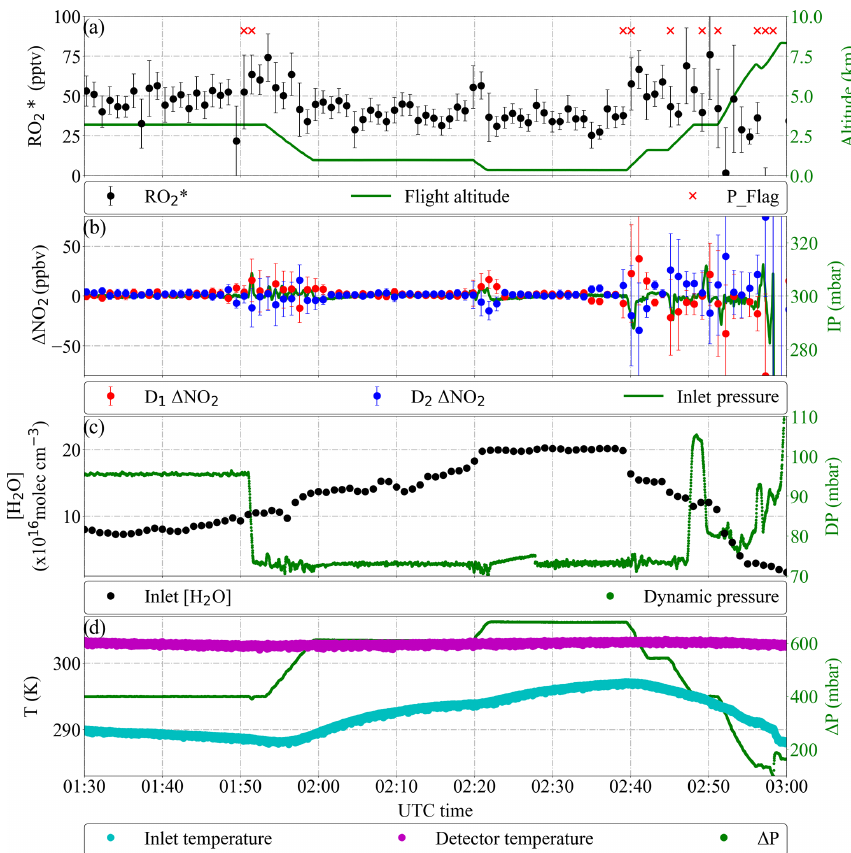
Figure 19. Detail of PeRCEAS measurements during the EMeRGe flight in Asia on 19 March 2018. The DUALER II inlet was operated with 45ppmv NO and at 300mbar. (a) Retrieved RO ∗ and flight altitude. Pressure variations with 1min standard deviation >2mbar are flagged 2 (red crosses). (b) (cid:49) NO 2 calculated from detector 1 (red dots), detector 2 (blue dots) and DUALER pressure. (c) Water number concentration in DUALER and dynamical pressure experienced by the aircraft. (d) DUALER inlet, detector temperature and pressure difference between inlet and outside pressure ( (cid:49)P